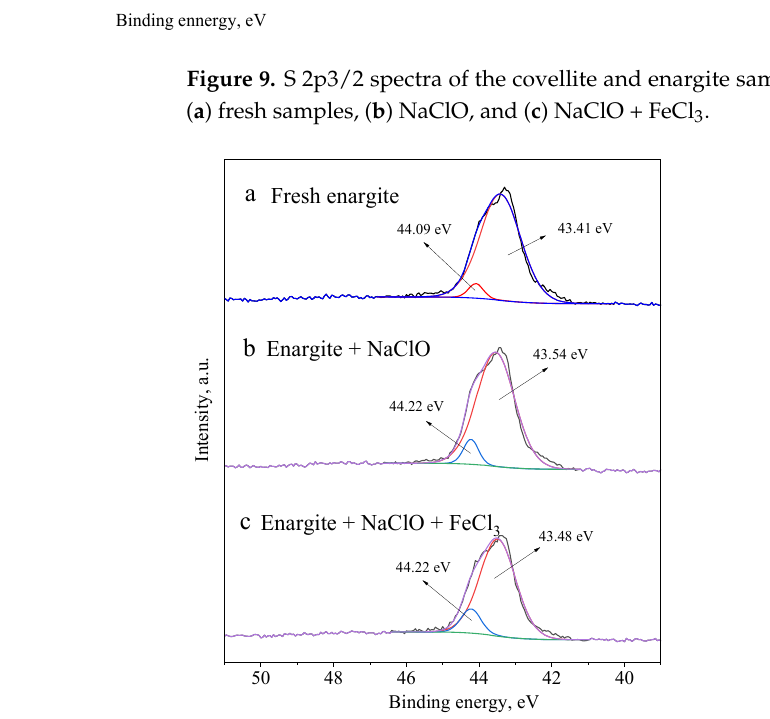
Figure 9. S 2p3/2 spectra of the covellite and enargite samples treated with different depressants: ( a ) fresh samples, ( b ) NaClO, and ( c ) NaClO + FeCl 3 .